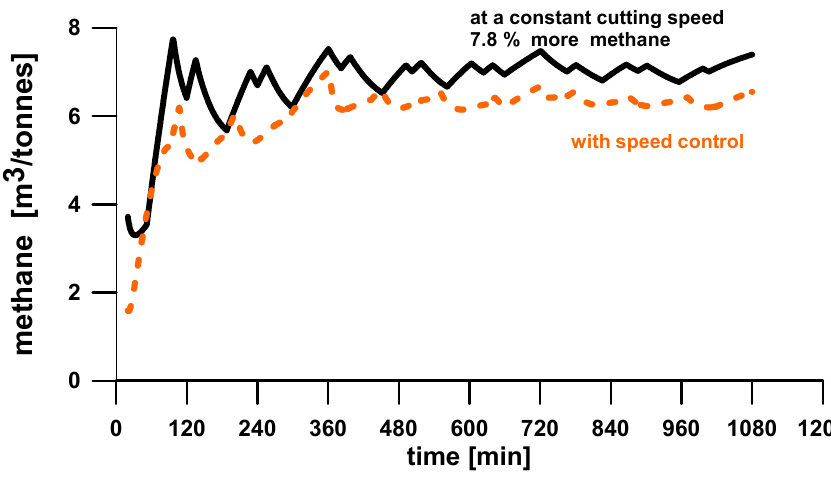
Figure 10. Changes in the methane volume flow per unit of production in the end of the tailgate where the intermittent orange line represents a case with speed control and the black line indicates a case without speed control.